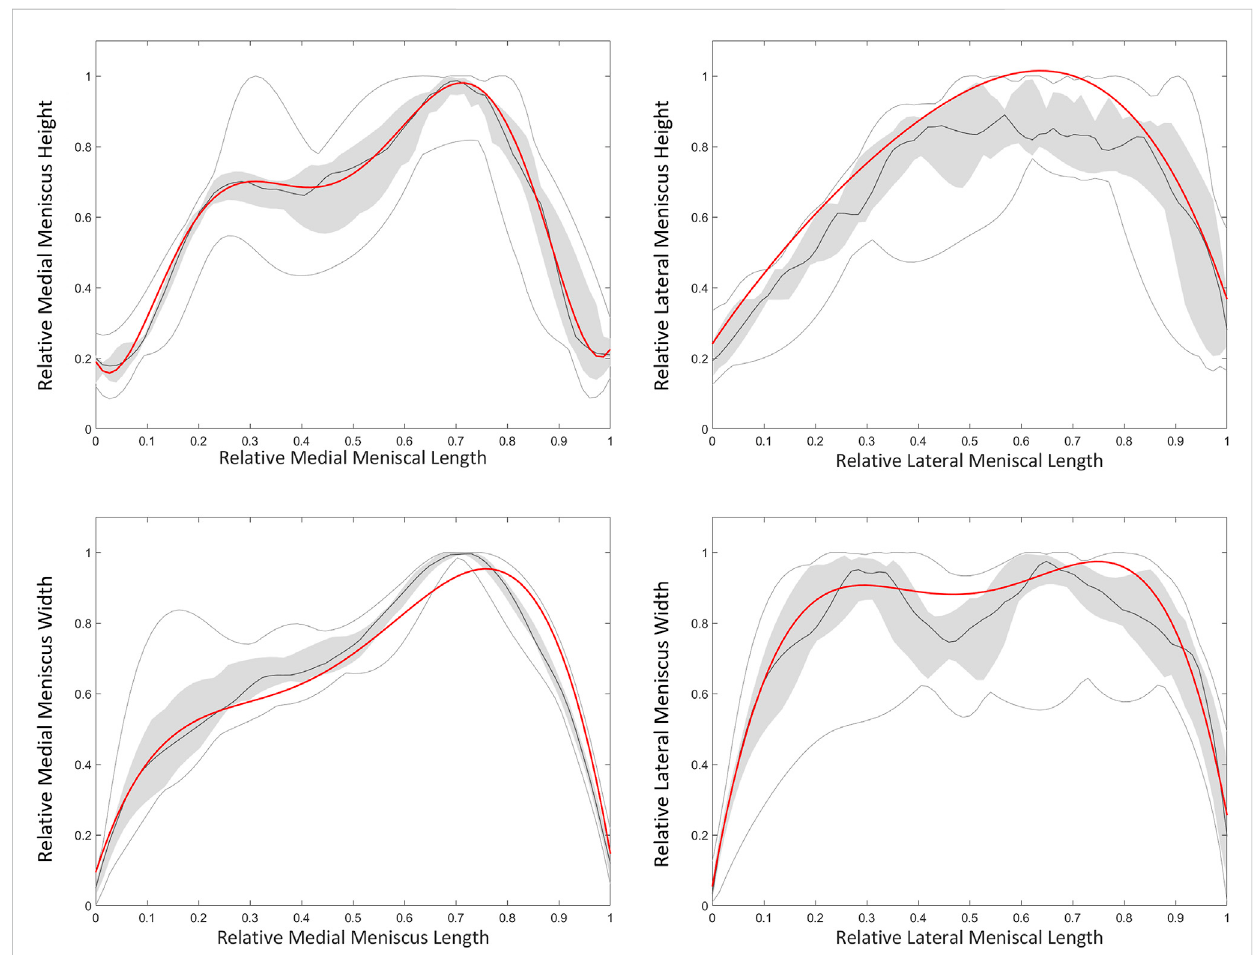
FIGURE 13 Polynomial fi tting for medial and lateral meniscal height and width prediction. The median height and width of the medial (left) and lateral (right) meniscusispresentedasthedarkgreyline.ThegreyzonerepresentsthevaluesbetweenP25andP75.Thelightgreylinesrepresentminimalandmaximal values. The red line represents height and width of respectively a 6th and 4th degree polynomial function for the medial meniscus. For the lateral meniscus, the red line represents twice a 4th degree polynomial fi t.